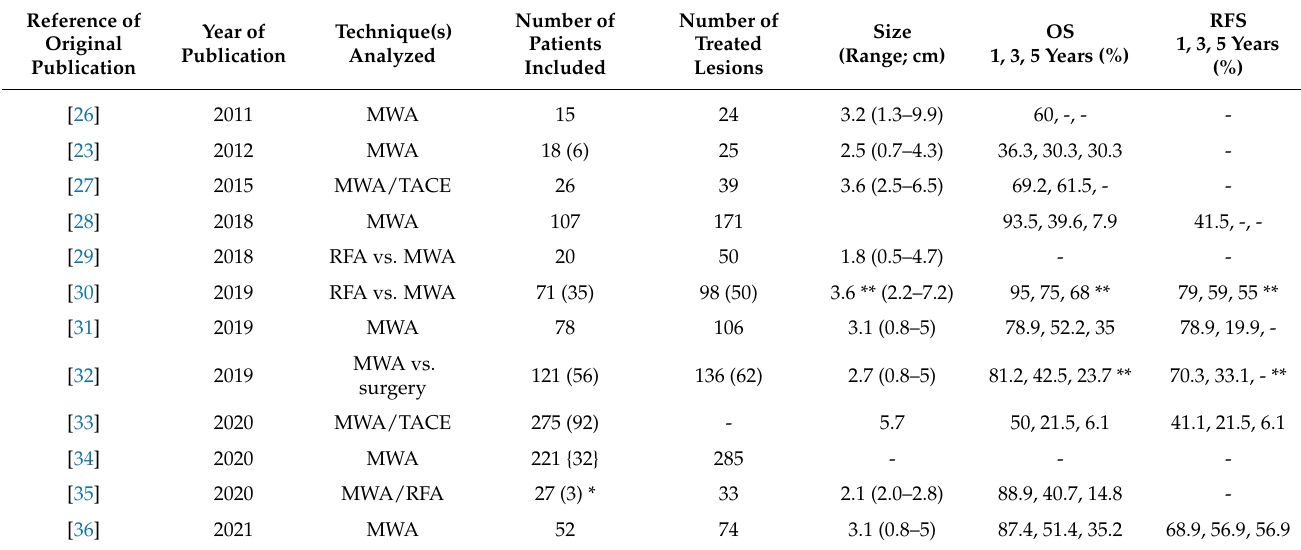
Table 1. Summary of the literature on MWA for